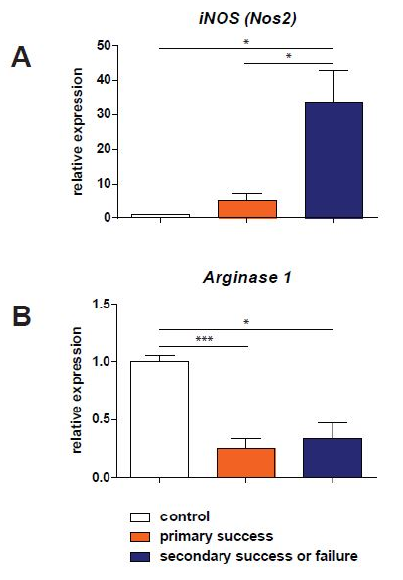
Figure 2. Relative expression of iNOS (Nos2, inducible nitric oxide synthase, panel ( A )) and Arginase- 1 (Arg1, panel ( B )). Results in control tissue are represented in white bars. Samples obtained from patients with subsequently successful RIA treatment are shown in orange. The failure of the treatment group is presented in dark blue. Levels of significance: *: p < 0.05 and ***: p < 0.001).